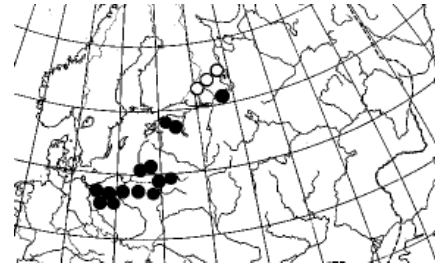
Fig. 7. Distribution of Steinia geophana in Eastern and East Central Europe (cid:2) records more than 50 year old, (cid:3) modern